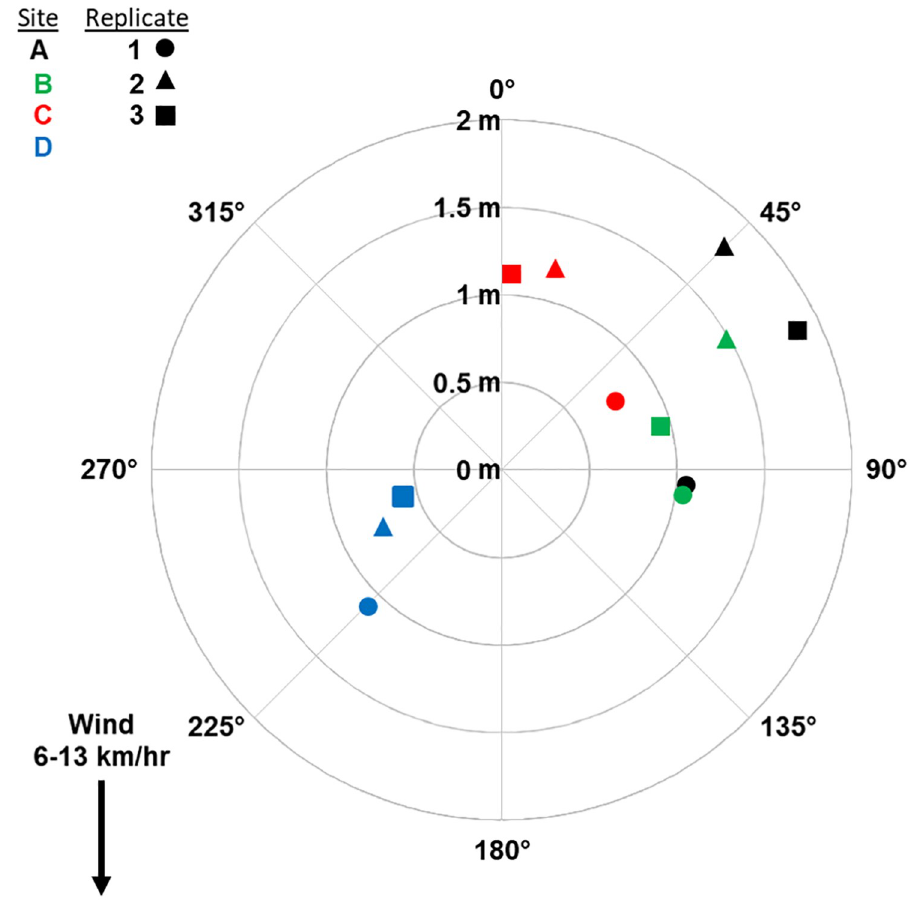
Fig 3. Placement accuracy of Natular XRT tablets autonomously dropped from a UAS. Distance (m) and position (degrees) of each tablet in relation to intended center target (0,0). Target sites are represented by color and replicates are designated by